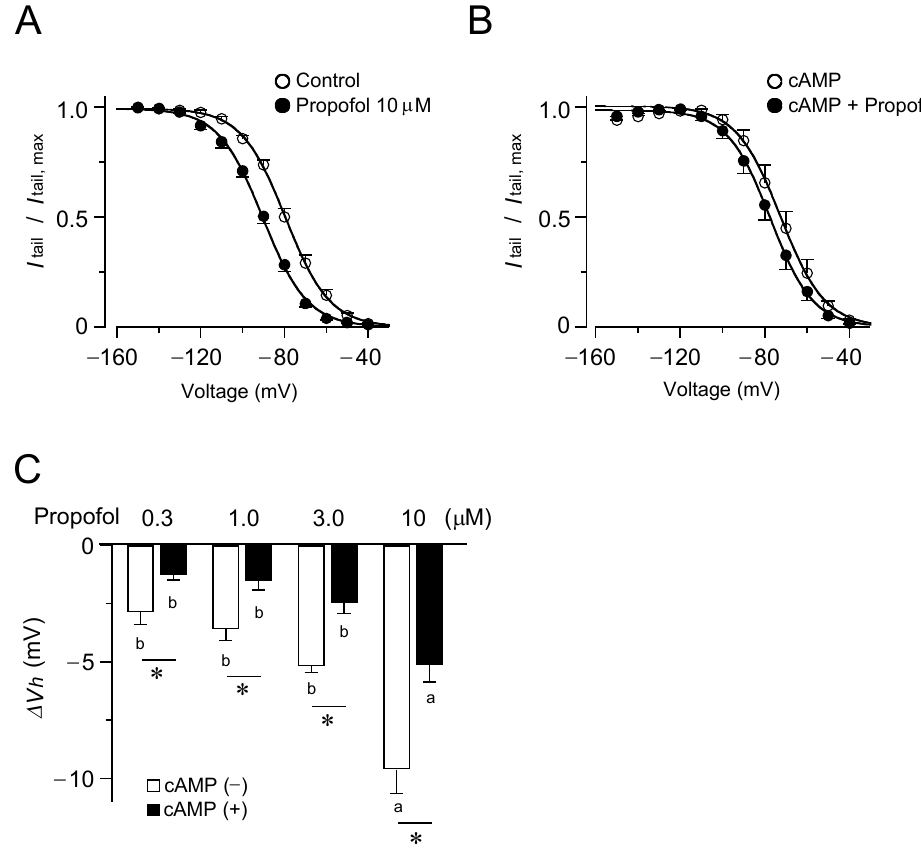
Figure 2. Propofol causes a hyperpolarizing shift in voltage dependence for HCN4 channel activation. The voltage dependence of HCN4 channel activation, in the presence and absence of propofol, was obtained from the cells using a pipette without ( A ) and with ( B ) cAMP. Tail current densities were normalized to the maximum value. The data points are mean ± S.E.M. ( n = 6) and the smooth curves are the fit to the data using the Boltzmann equation. ( C ) Shifts in V h caused by propofol at various concentrations in the presence and absence of cAMP. Bars represent the mean ± S.E.M. ( n = 6), and those followed by different letters indicate a significant difference at p < 0.05 according to the Tukey’s multiple range test and t -test (* indicates the difference in the presence and absence of cAMP; a, b, indicate different propofol